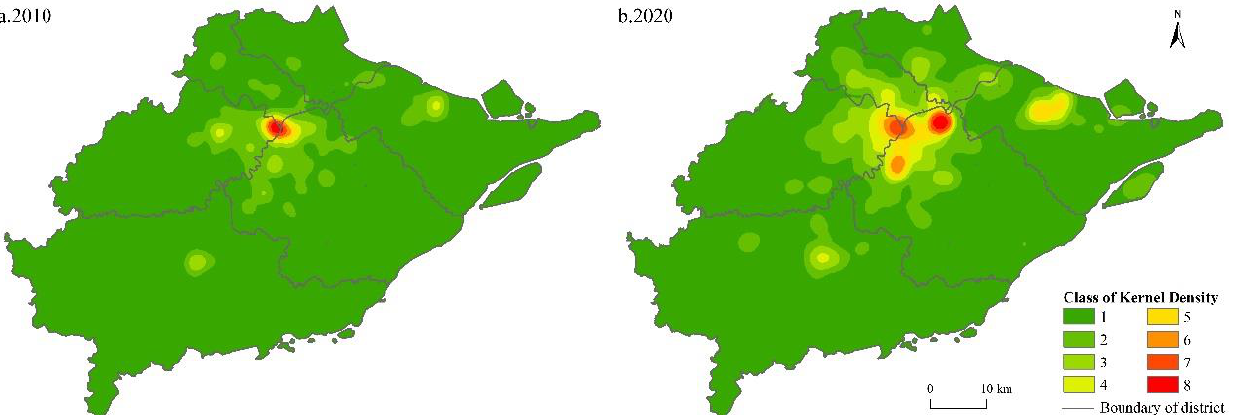
Figure 4. Kernel density of cultural enterprises in the central district of Ningbo in ( a ) 2010 and ( b ) 2020. Note: This map is based on the standard map of the Map Technical Review Centre of the Ministry of Natural Resources of China (Number: Zhejiang S (2022)34), with no modifications to the base map. Map-making by the author.